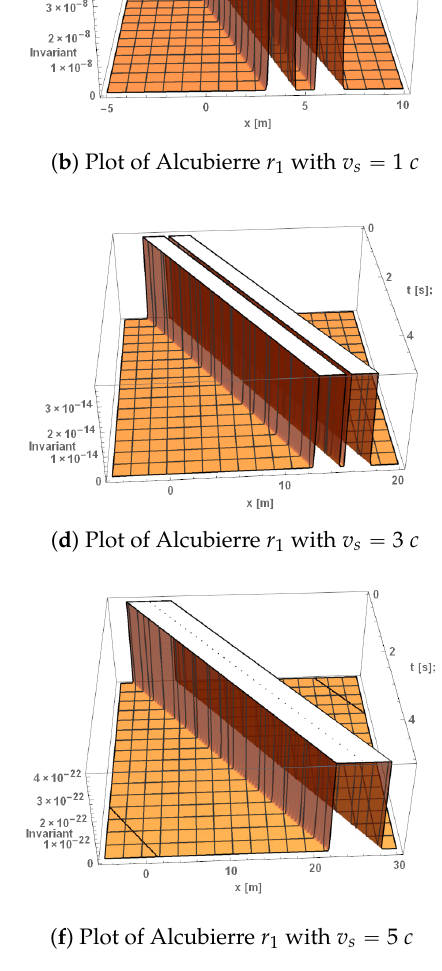
Figure A1. Plots of the r 1 invariants for the Alcubierre warp drive while varying velocity. The other parameters were chosen as σ “ 8 m ´ 1 and ρ “ 1 m to match the parameters Alcubierre originally suggested in his paper [1]. Equation (8) is in natural units, so the speed of light was normalized out of the equation. The factor of c was included in these captions to stress that the plots are of multiples of the speed of light. Their units are ms ´ 1